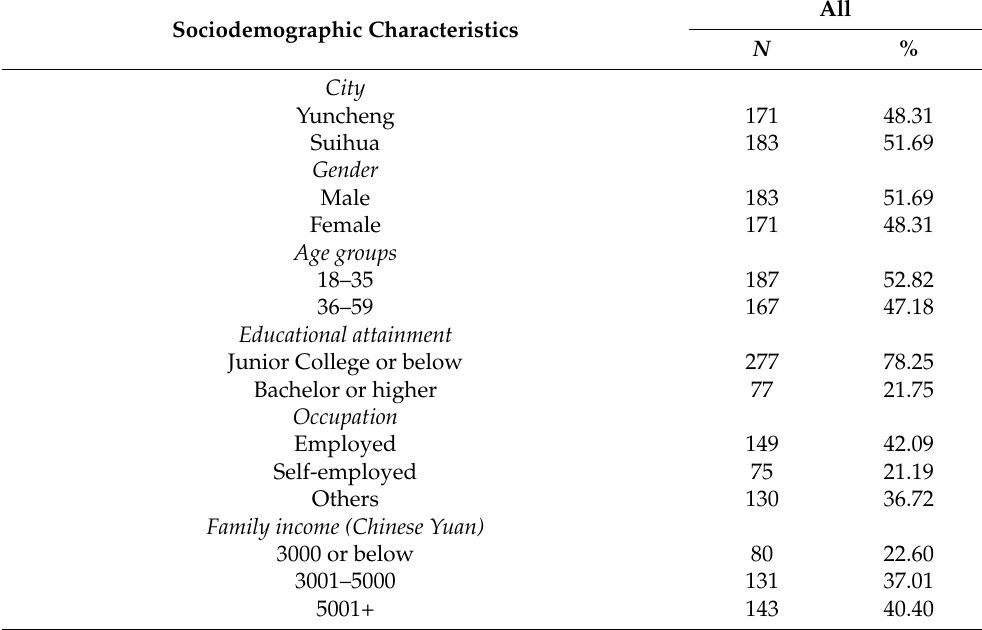
Table 2. Descriptive analysis of sociodemographic